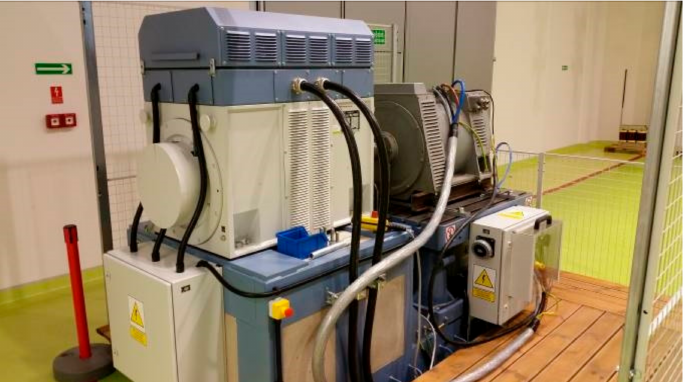
Figure 4. Diagram of the measurement setup for short-circuit and voltage recovery tests.